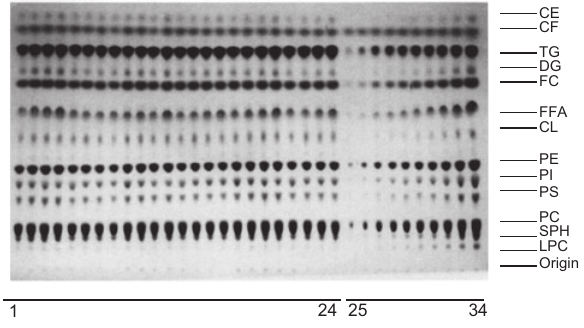
Figure 4 Representative thin-layer chromatogram of neutral lip- ids and PLs developed in stepwise fashion. A lipid extract portion (1 µ l) from homogenates of eight different rat hepatocyte popula- Figure 5 2D-TLC of cream polar lipids. Molybdate-positive spots